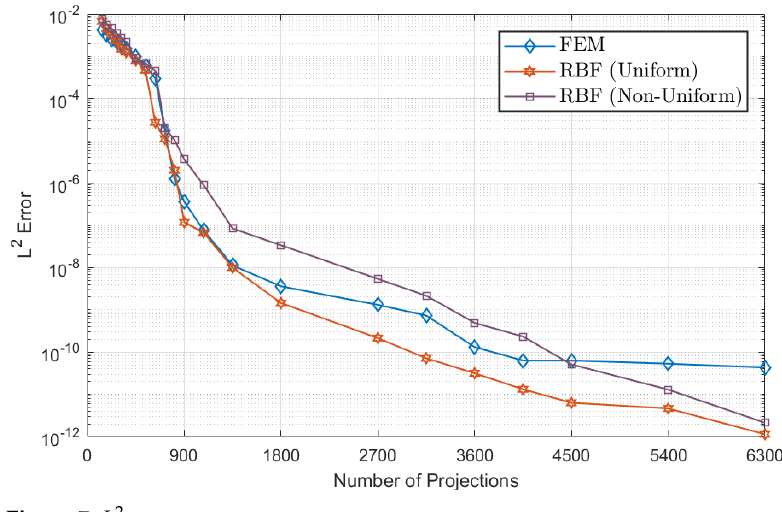
Figure 7. L 2 error.